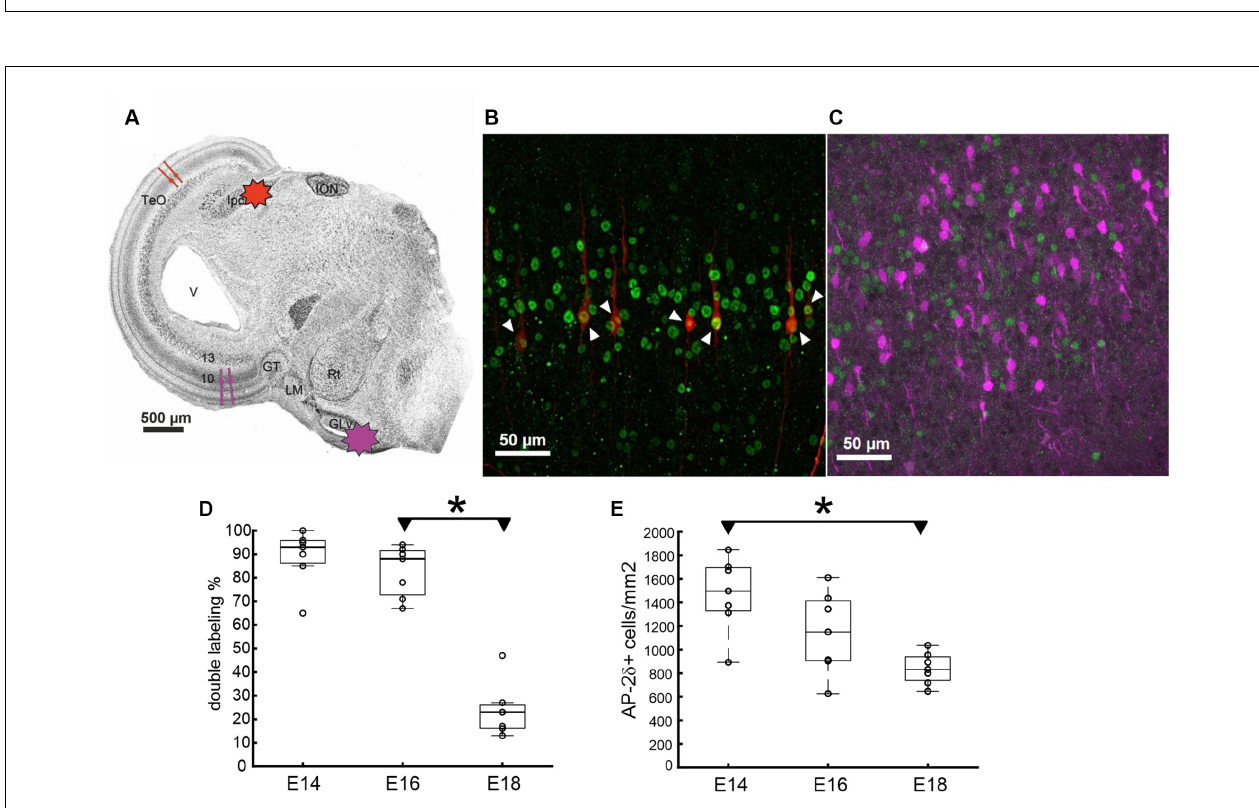
FIGURE 6 | Localization of AP-2 δ expression in the optic tectum (TeO). (A) Chicken brain slice showing the sectioning angle and the schematic injection areas for the tracer to label different cell populations in layer 10 of the TeO. (B,C) Double labeling with BDA tracing from either the Ipc ( B , red) or the Glv ( C , violet) in combination with AP-2 δ labeling (green) in an E16 brain slice. Co-localization of BDA tracer and AP-2 δ in shepherd’s crook neurons (SCN) indicated by double labeling in (B) (white arrows). No co-localization was found after BDA injection into Glv. ION, Nucleus isthmo-opticus ; Ipc, N. isthmi parvocellularis ; Glv, N. geniculatus lateralis pars ventralis ; GT, Griseum tectalis ; LM, N. lentiformis mesencephali ; Rt, N. rotundus . (D) Percentage of double labeled SCN neurons at E14–E18 with individual data points at n = 7 random slice sections from one brain at each embryonic state. Zero double labeled cells in layer 10 (L10) after BDA injection in Glv. (E) AP-2 δ immunopositive cell density for the same sections (area 0.975 mm 2 , depth 40 µ m) as in (D) . Boxplots show median and interquartile range (asterisks: Tukey-Kramer multiple comparison test, p < 0.01).